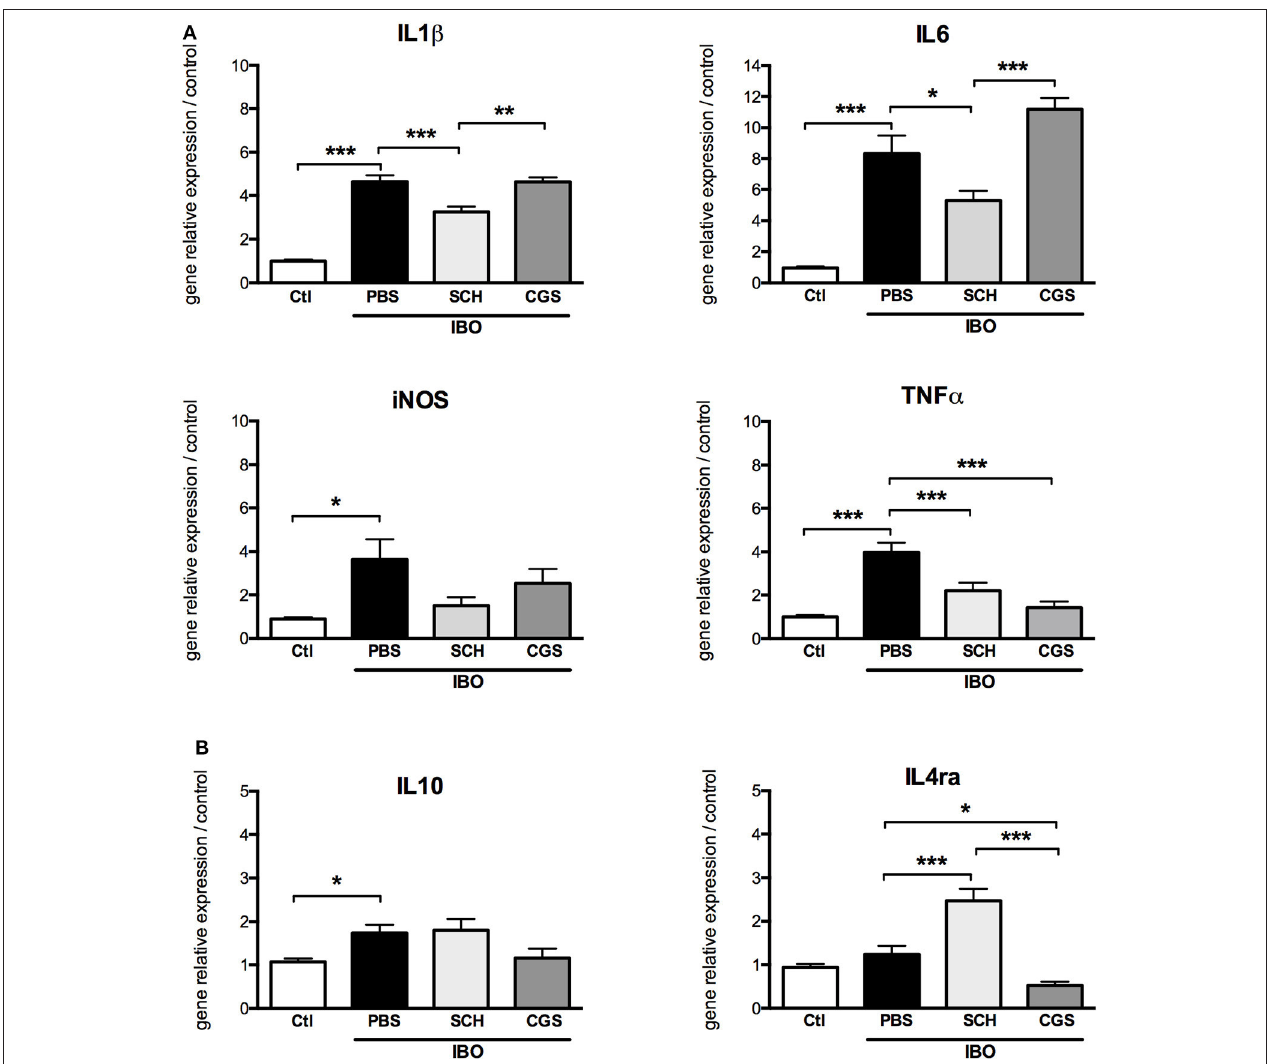
FIGURE 8 | A2aR modulation regulates the phenotype of microglial sorted cells exposed to 300 µ M ibotenate (IBO) for 6h. Quantification of gene relative expressions of M1 (A) and M2 (B) proteins in microglial cells treated with or without SCH-58261 (A2aR antagonist) and CGS-21680 (A2aR agonist) sorted from control or LPD animals (* p < 0.05, ** p < 0.01, *** p < 0.001, using one-way ANOVA followed by Newman-Keuls post-hoc